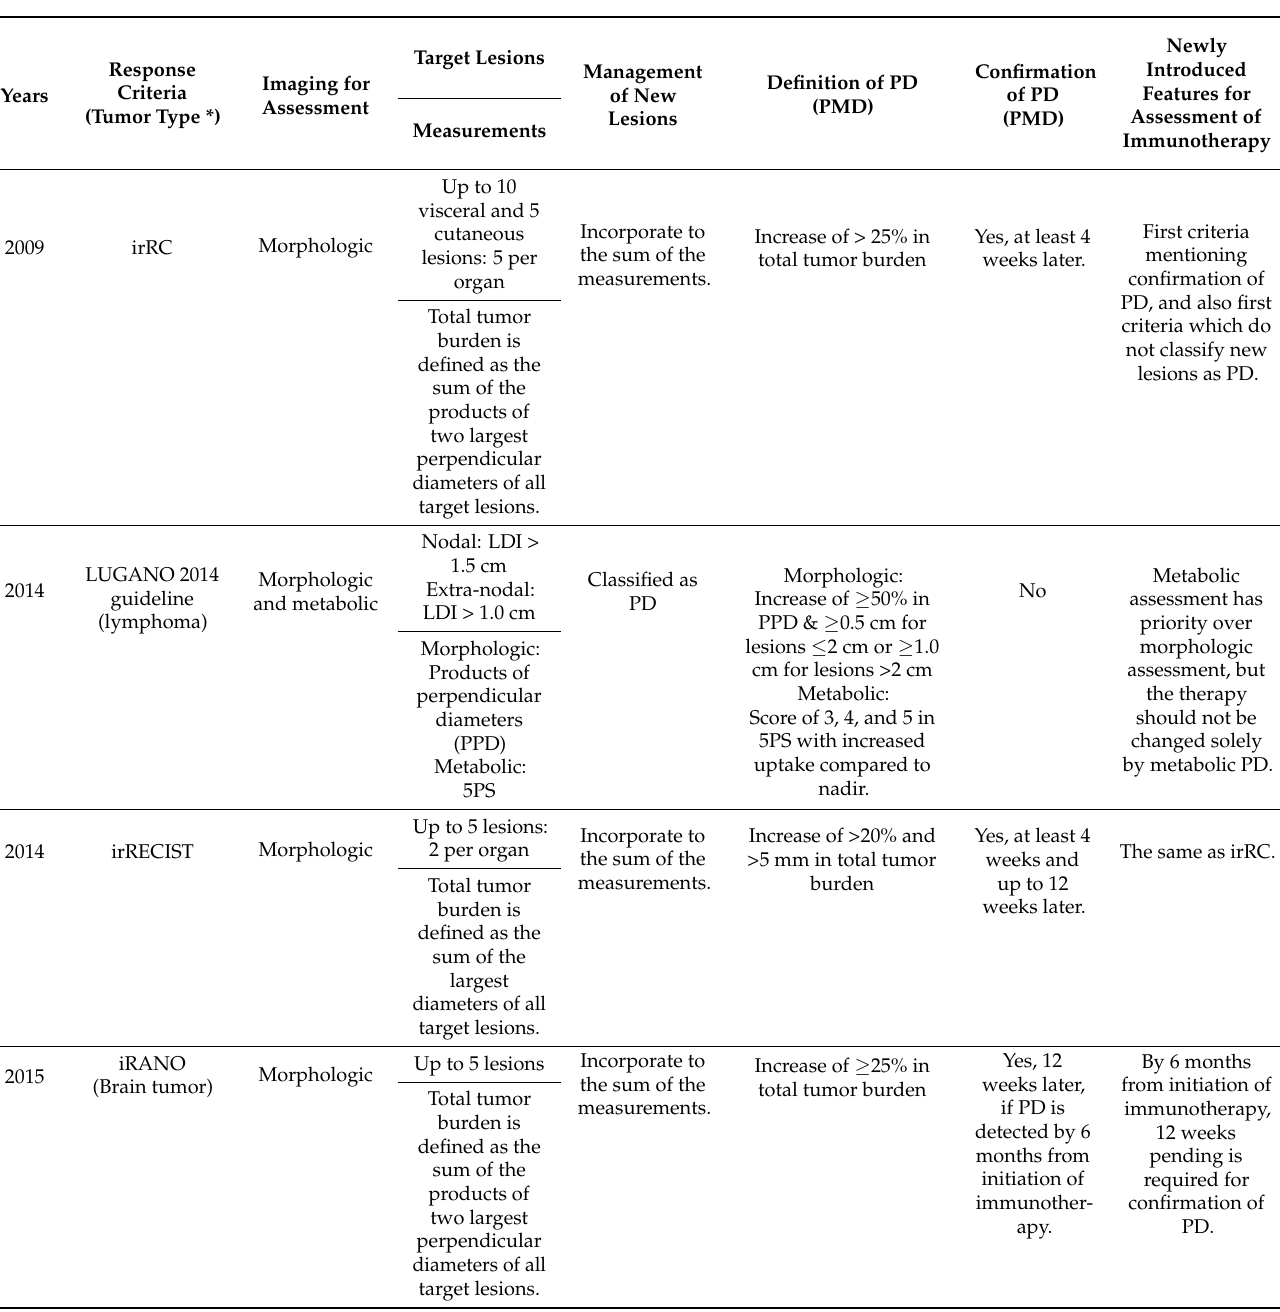
Table 2. Response criteria for